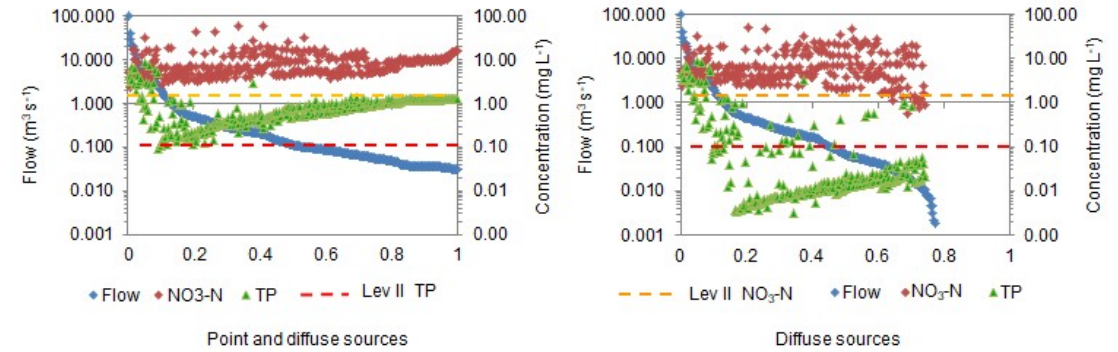
Figure 4. Flow duration curve and daily concentrations of NO 3 -N and TP for baseline ( left ) and for non-WWTP discharge into the river ( right ).